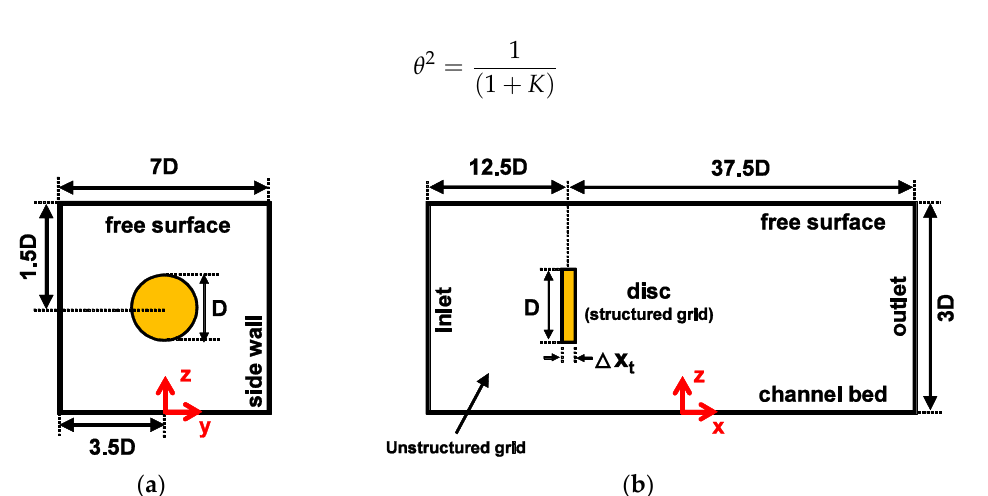
Figure 1. Schematic diagram showing views from the inlet ( a ) and channel side ( b ). The front view displays the swept area of the turbine of diameter, D = 20 m.